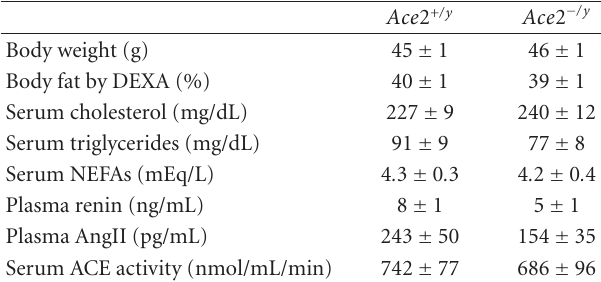
Table 1: Characteristics of chimeric HF-fed mice transplanted with Ace2 + /y or − /y bone